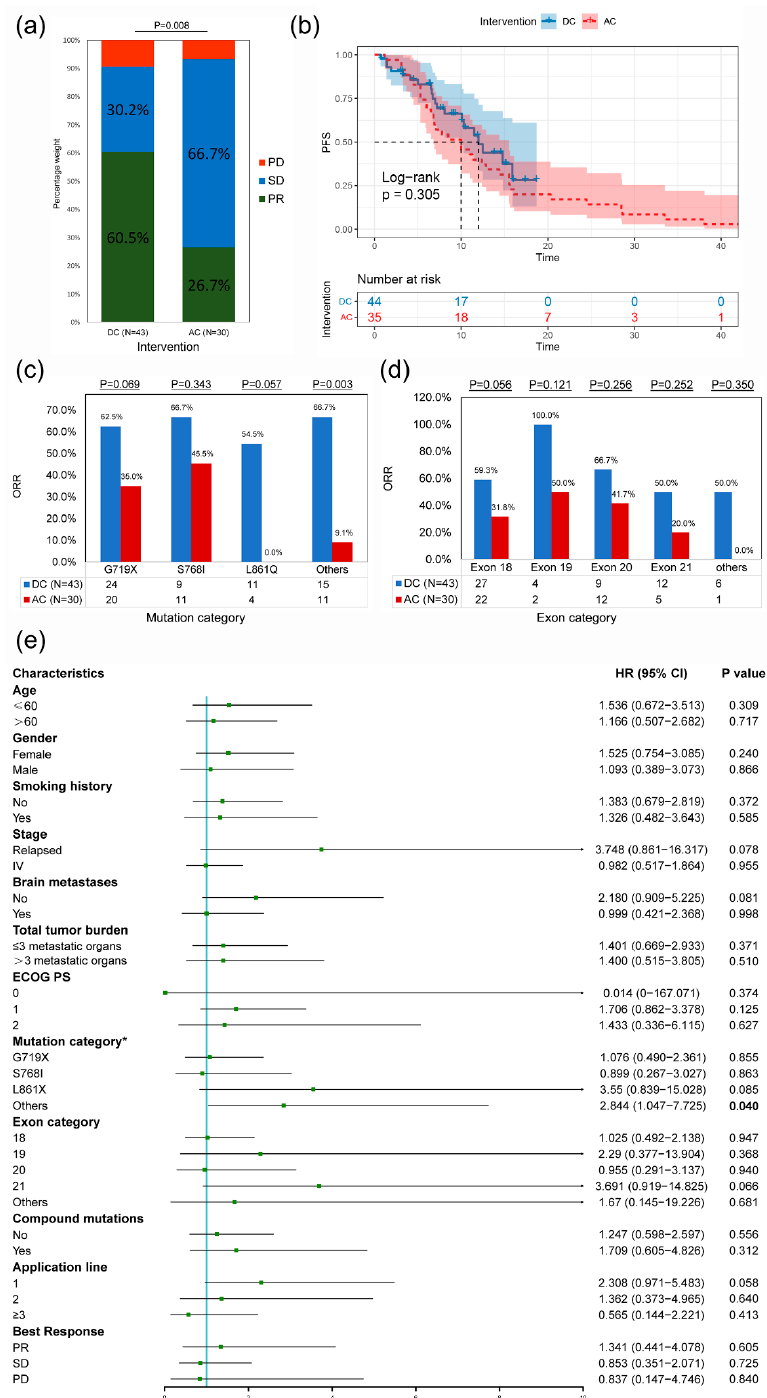
Figure 2. Comprehensive comparison between the DC and the AC. Stacked histogram of treatment responses ( a ), Kaplan-Meier curves ( b ), ORRs of different mutation categories ( c ), ORRs of different exon categories ( d ), and subgroup analysis of PFS ( e ) of the DC and the AC. ORR, objective response rate; PFS, progression-free survival; DC, dacomitinib cohort; AC, afatinib cohort; PR, partial response; SD, stable disease; PD, progressive disease; HR, hazard ratio; CI, confidence interval; ECOG PS, Eastern Cooperative Oncology Group performance status. * Uncommon mutation categories overlap with compound mutations, so each patient might belong to more than one